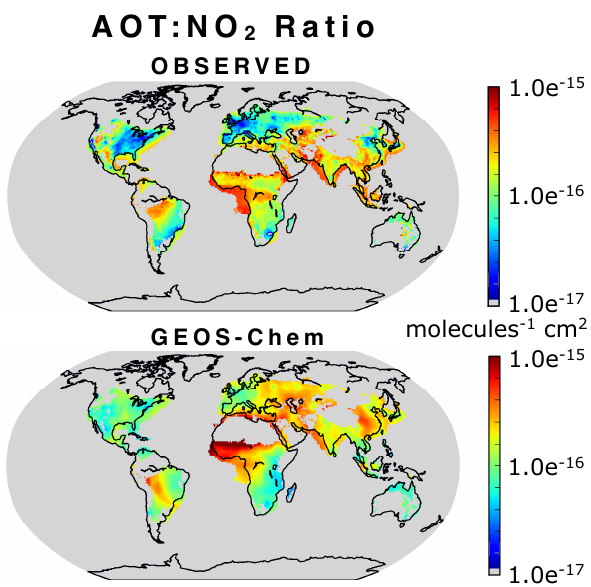
Fig. 4. Top panel: observed AOT to NO 2 ratio for regions where tropospheric NO 2 exceeds 7 × 10 14 moleculescm − 2 . Bottom panel: modelled AOT to NO 2 ratio for the same regions as the observa- tions. Note that a logarithmic colour scale is